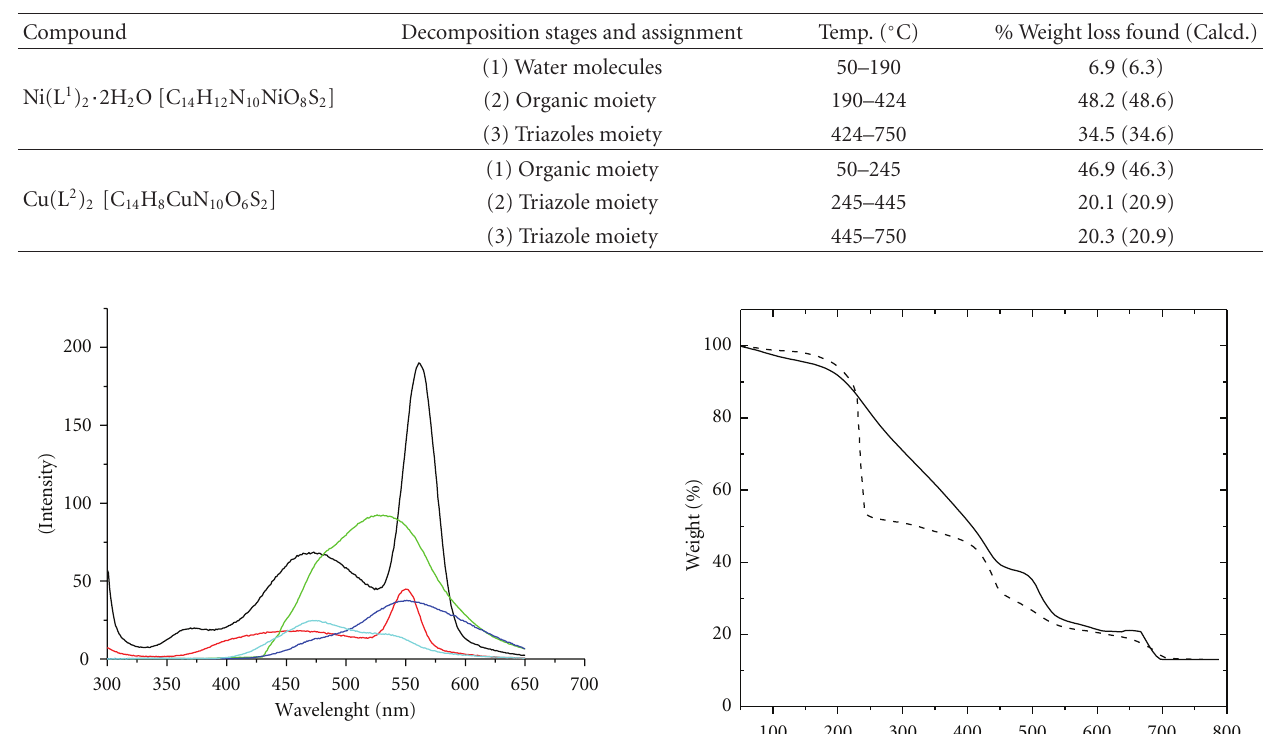
Table 4: Thermogravimetric data of Ni(L 1 ) 2 · 2H 2 O and Cu(L 1 ) 2 complexes.